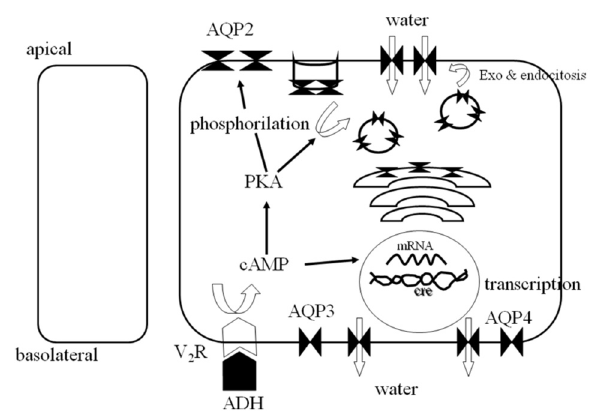
Figure 1 - Illustrative model of the arginine vasopressin (AVP) action in a collecting tubular cell, showing the AVP binding to V2 receptor (V2R), causing the deflagration of a cascade of events. The final result is the mi- gration of water channels (AQP2) to the luminal surface with consequent water